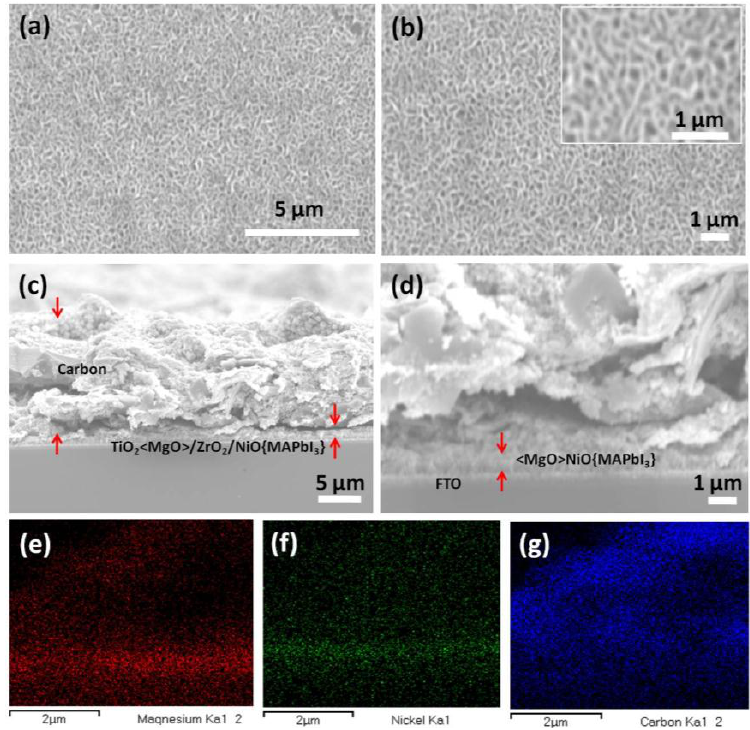
Figure 2. Surface topographical images of electrodeposited Mg(OH) 2 on the FTO substrate for ( a ) 2 min and ( b ) 10 min (inset shows the higher magnification), cross-sectional images of PSCs device B ( c ) and device D ( d ) and EDX mapping images of the MgO layer ( e ), NiO layer ( f ) and Carbon ( g ) in the device D.